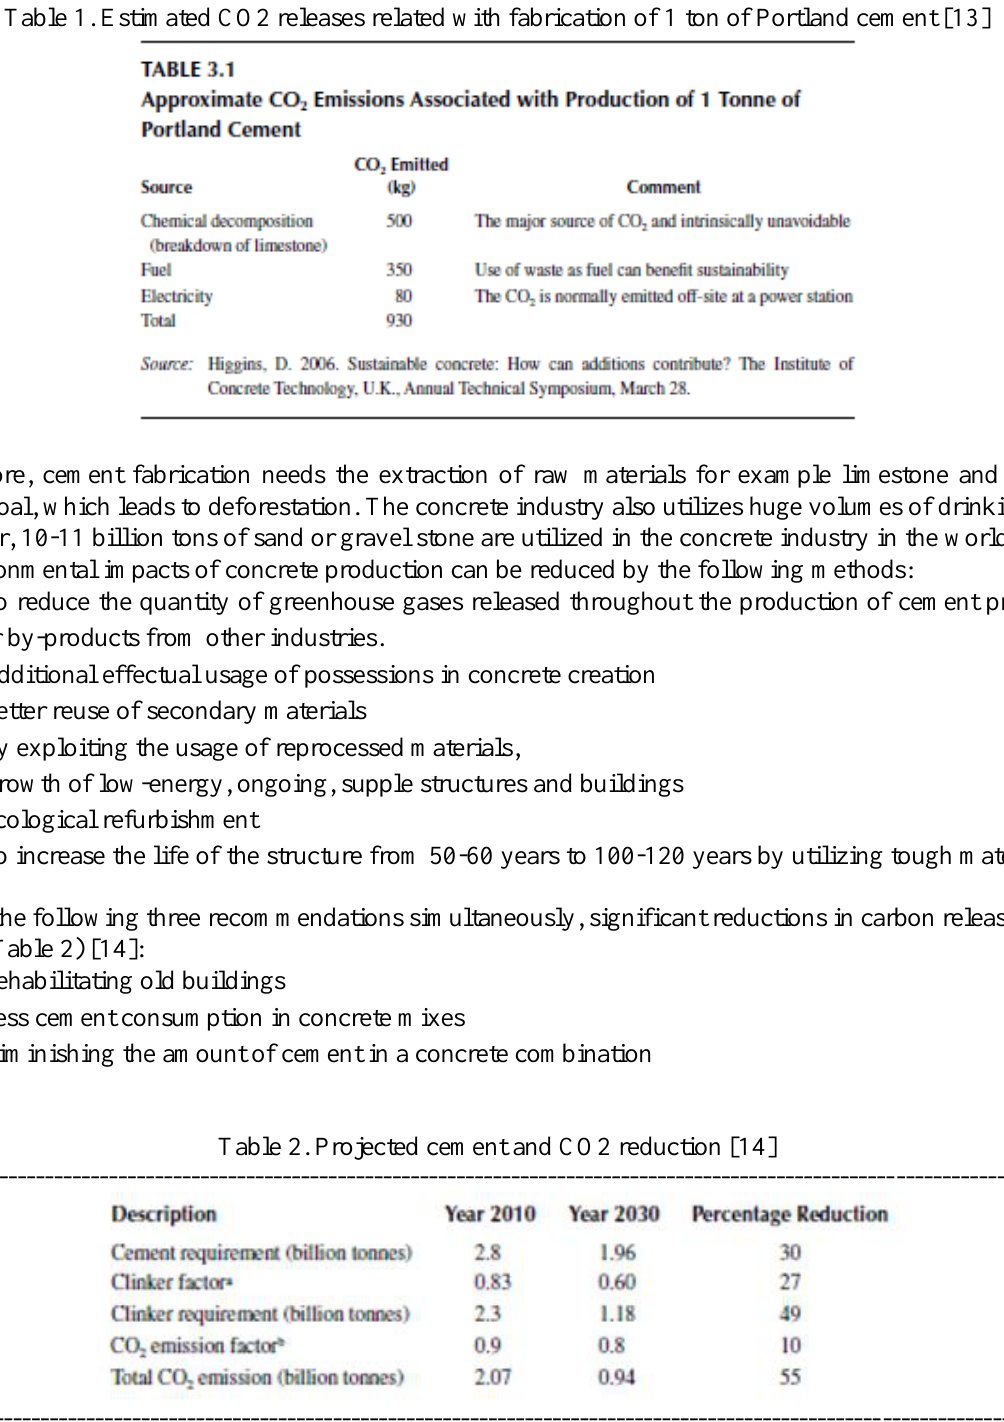
Table 1. Estimated CO2 releases related with fabrication of 1 ton of Portland cement [13]